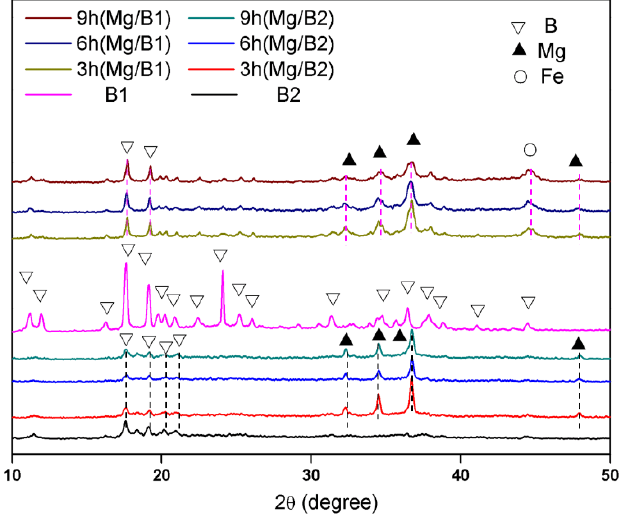
Figure 2. XRD patterns illustrating Mg/B composite powders.